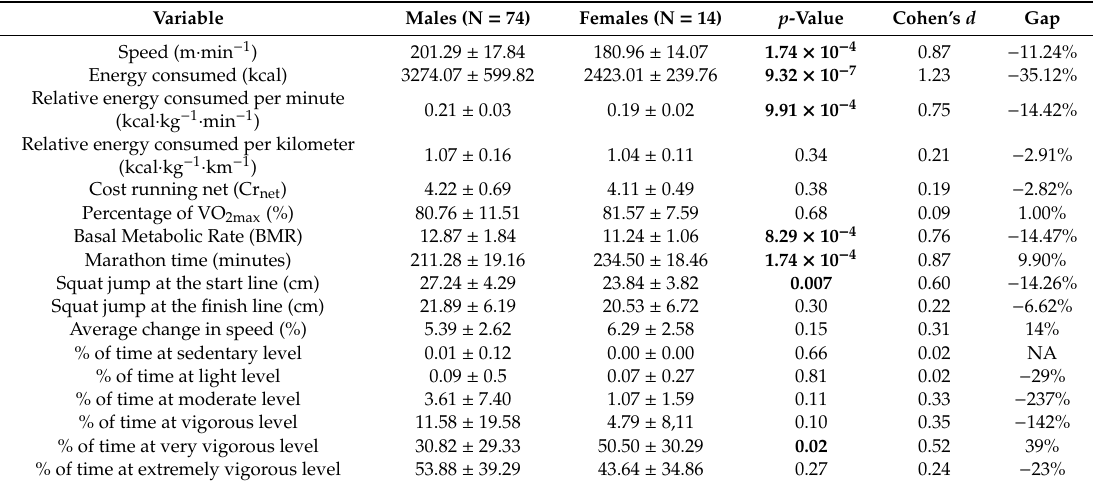
Table 3. Comparison of the di ff erent variables collected over the whole marathon distance between males and